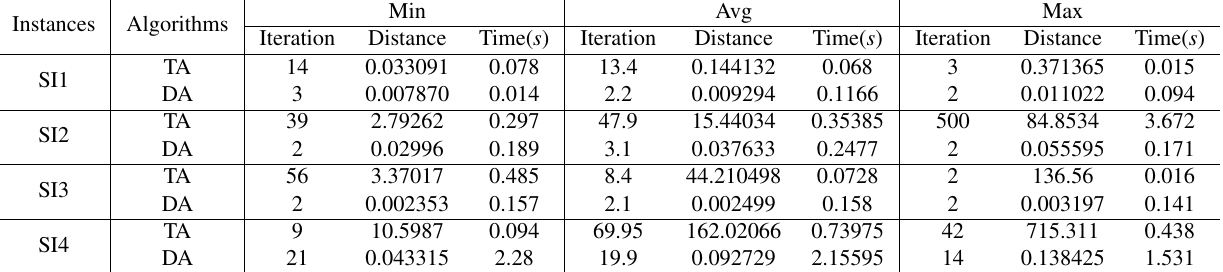
Table 3. The experimental results of the TA and DA algorithms under Case 2